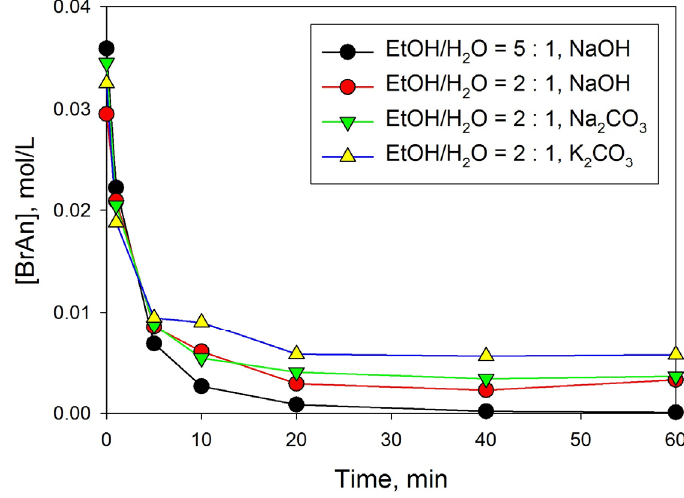
Figure 4. Influence of EtOH-to-H 2 O ratio and base on the activity of reduced Pd(0)/HPS (0.47 mol.% Pd, 1 mmol BrAn, 1.5 mmol PBA, 2 mmol of base, 70 °C, N 2 , 800 two-sided shaking/min).